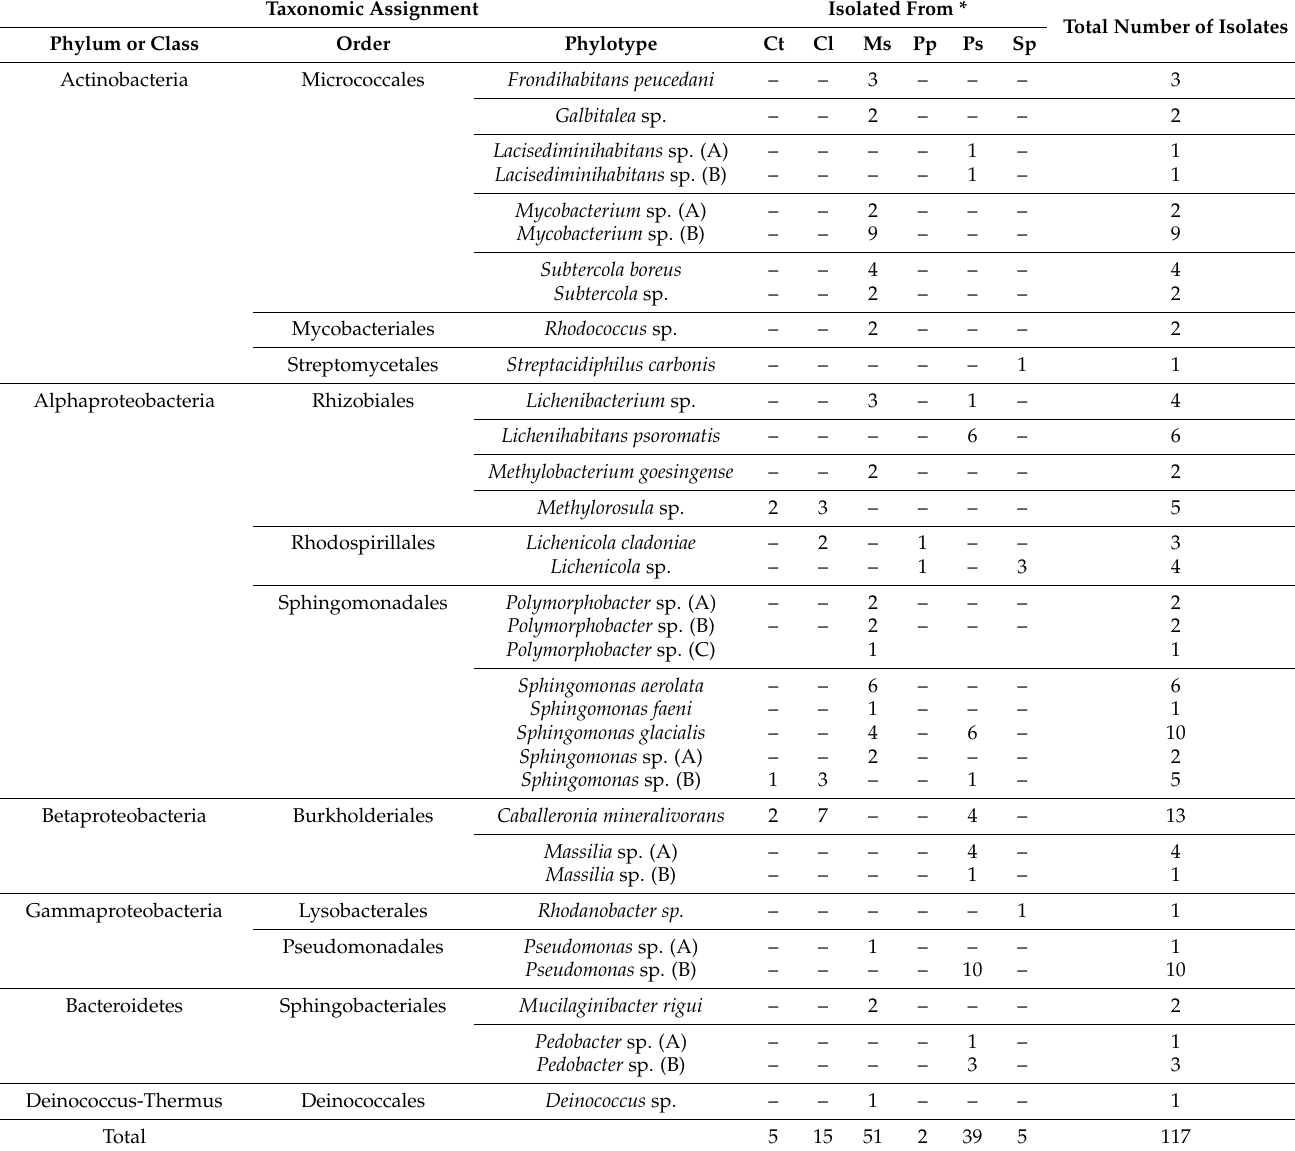
Table 2. Distribution of bacterial isolates according to